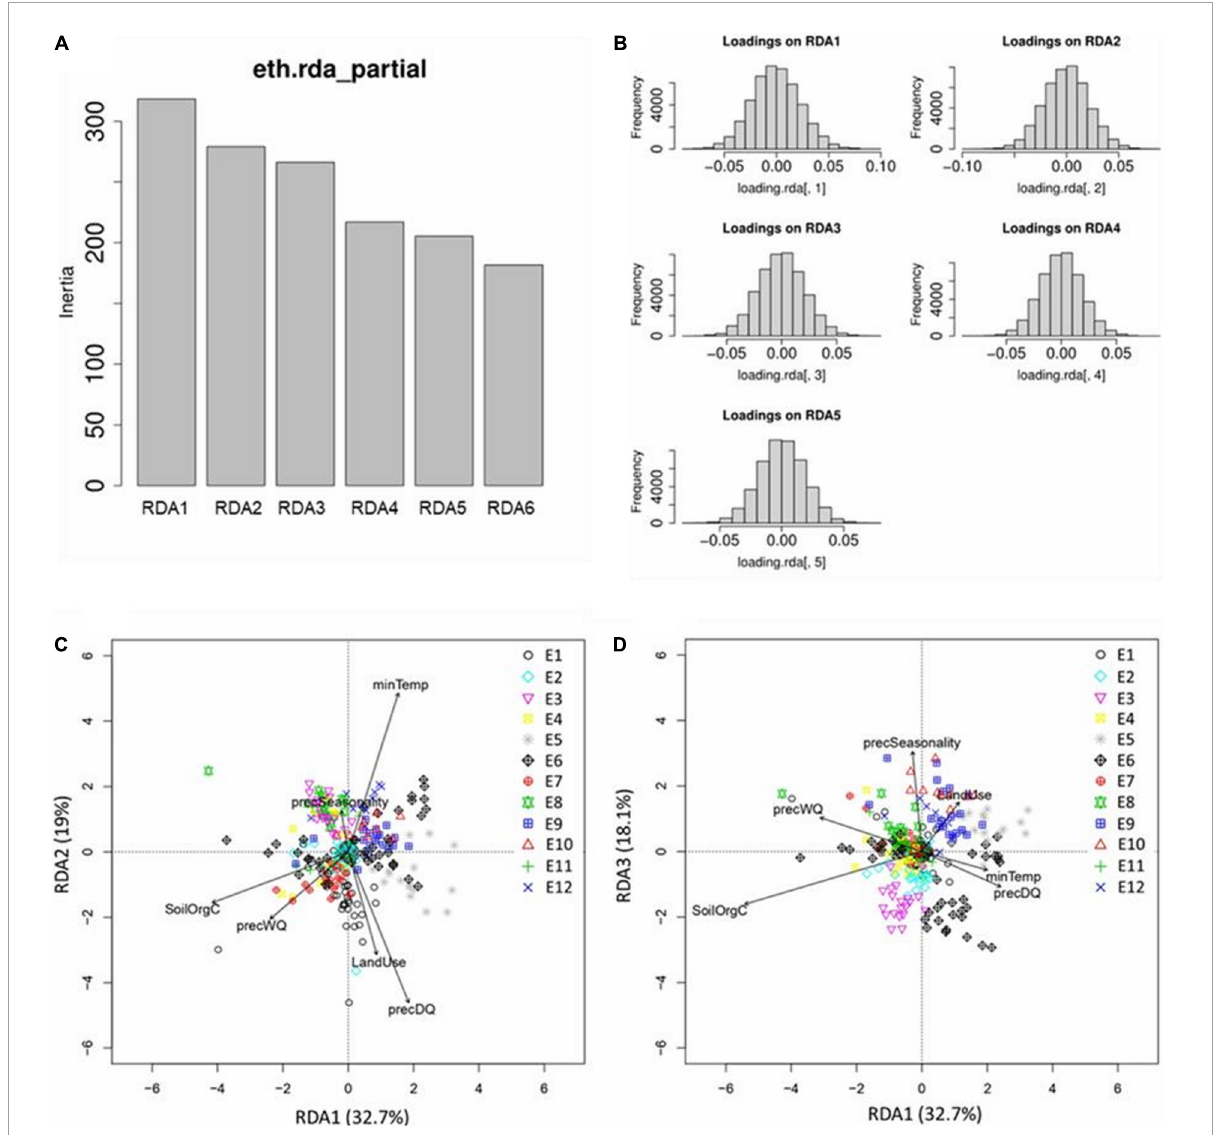
FIGURE7 Results from RDA analysis. (A) Projection of SNPs and environmental variables into the RDA space RDA1–RDA2 and (B) RDA1–RDA3; (C) variance (inertia) explained by the six RDA axes; and (D) distribution of SNP loadings for significantly constrained axes (RDA1–RDA5).